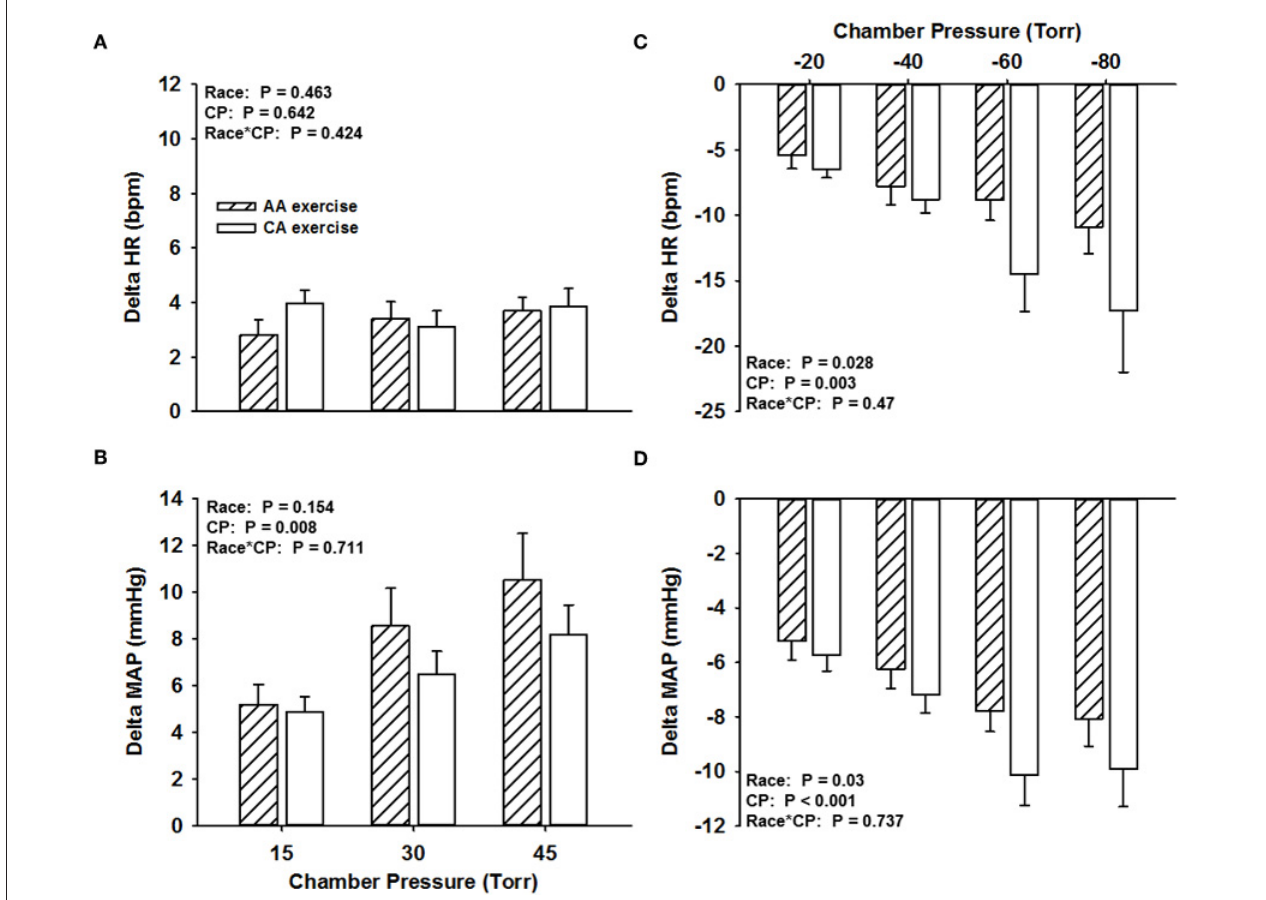
FIGURE 2 | Change in HR (A) and MAP (B) in response to NP and change in HR (C) and MAP (D) in response to NS in African Americans (AA, hatched bars) and Caucasian Americans (CA, open bars) during exercise. CP, chamber